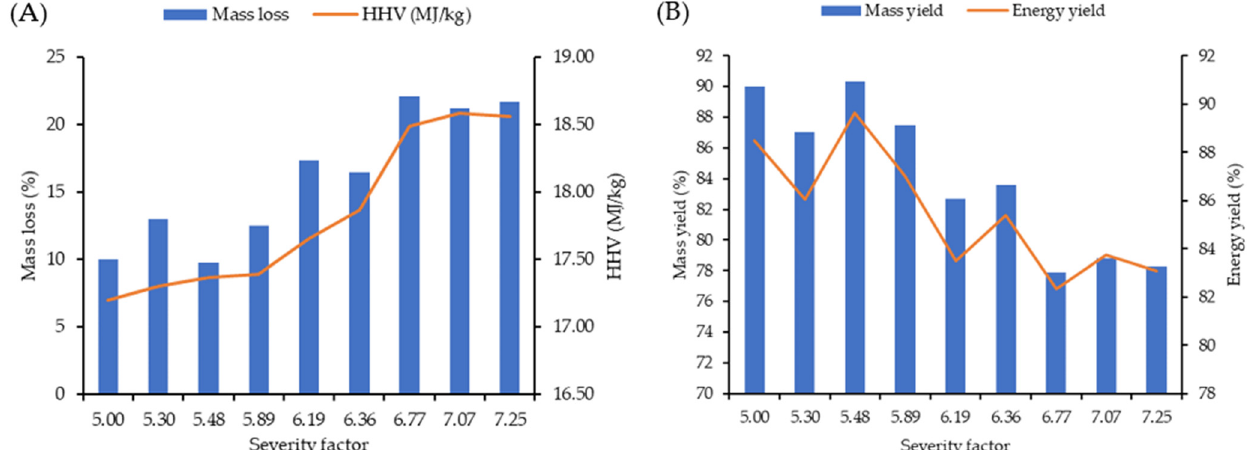
Figure 4. Relationship between mass loss and higher heating value with severity factor ( A ); and mass and energy yield with severity factor ( B ) of torrefaction process using inside temperature.